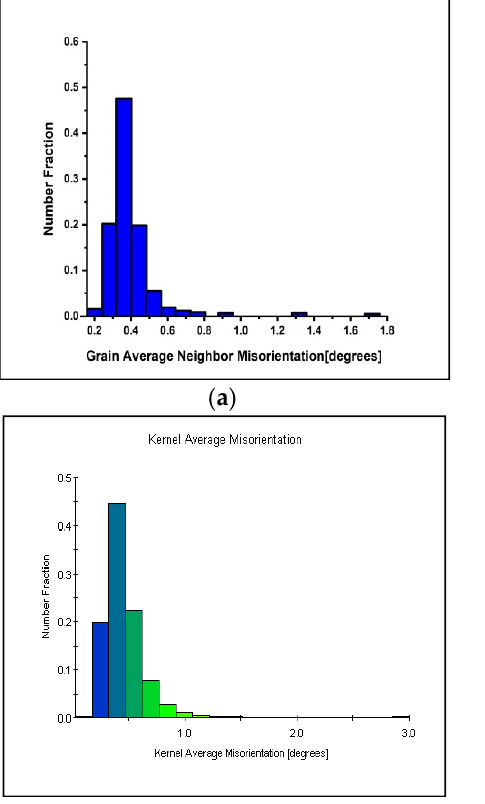
Figure 7. Frequency histograms of grain boundary misorientation of the high temperature ECAPed sample after ( a ) no pass, ( b ) first pass, ( c ) second pass, ( d ) third pass.